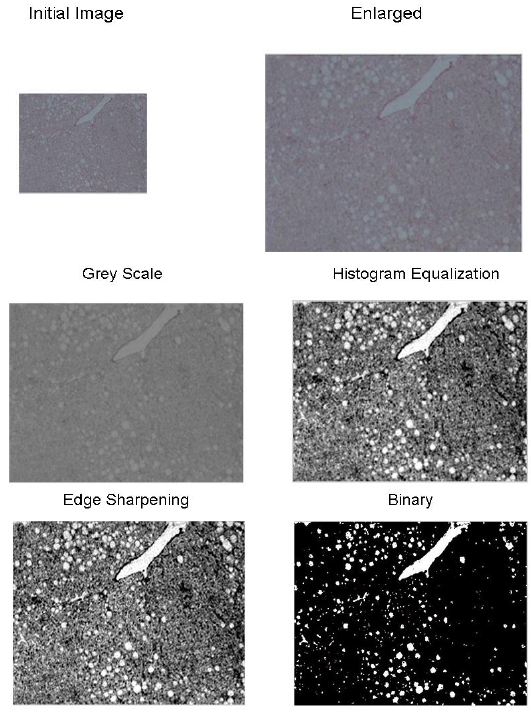
Figure 3. Image processing steps in the first stage.